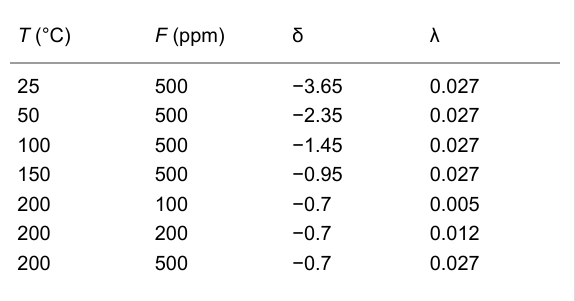
Table 1: Different temperature and concentration values with respec- tive parameters δ and λ